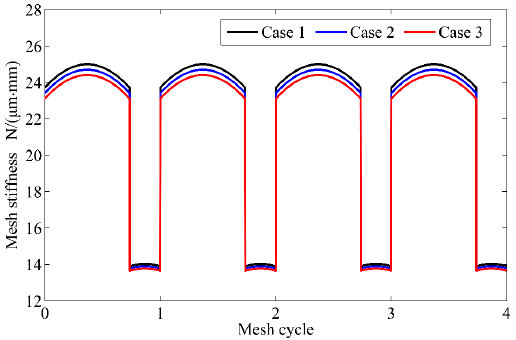
Figure 4. The time-varying mesh stiffness.